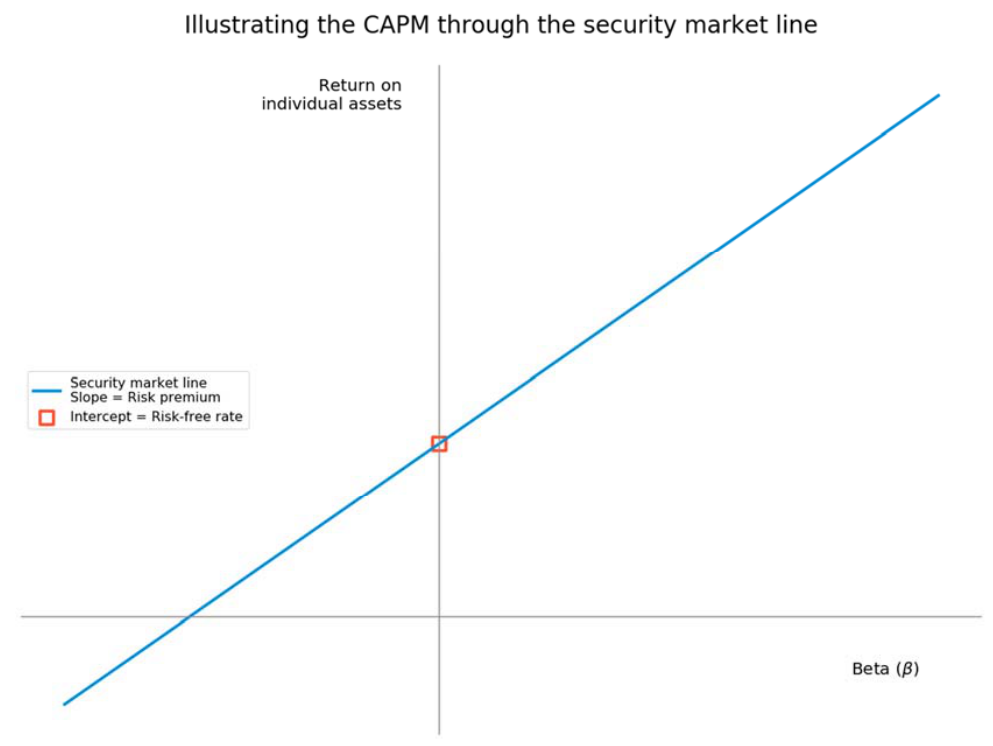
Figure 2. The security market line represents the CAPM as a linear function.